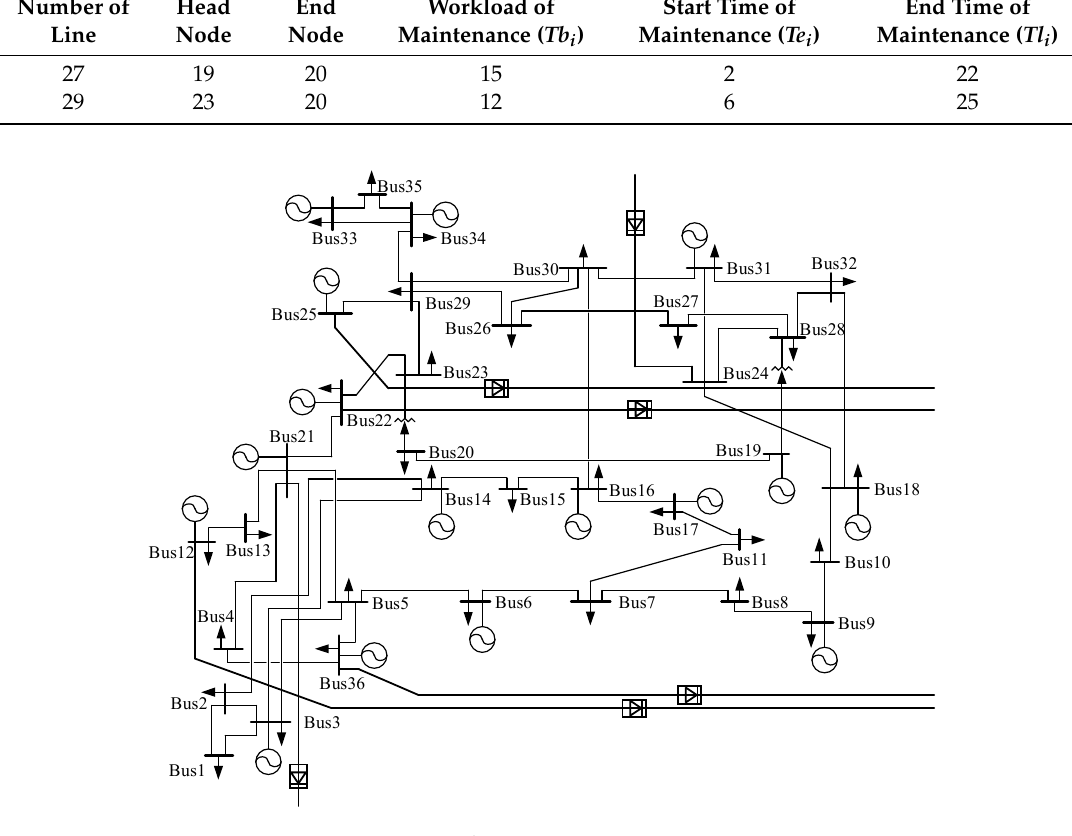
Figure 9. Hubei Province power system. Table 4. Information of the overhead transmission lines to be maintained in Hubei Province.